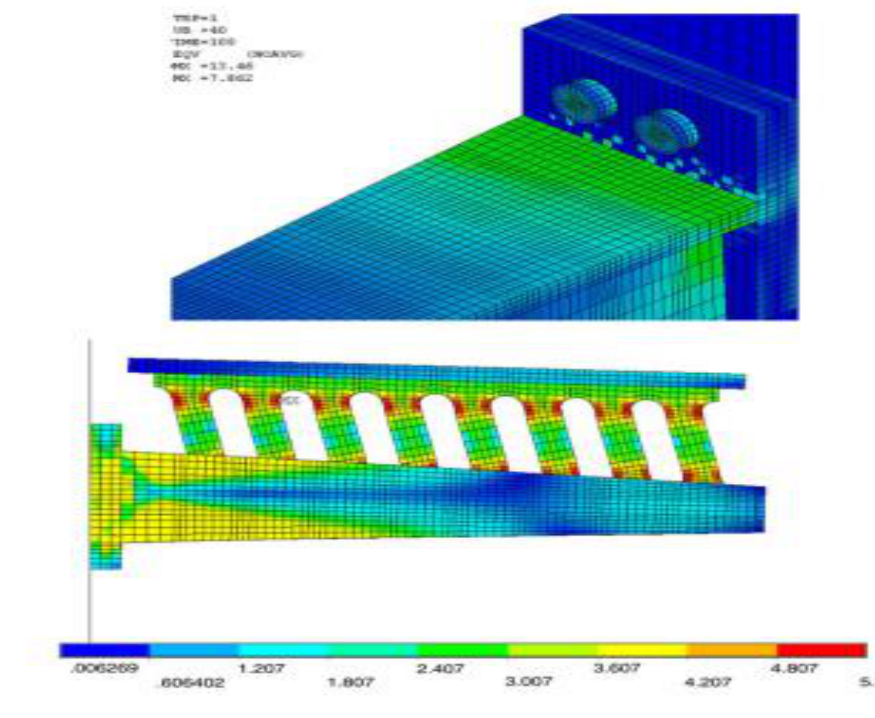
Figure 10. von misses stress contour specimen D2